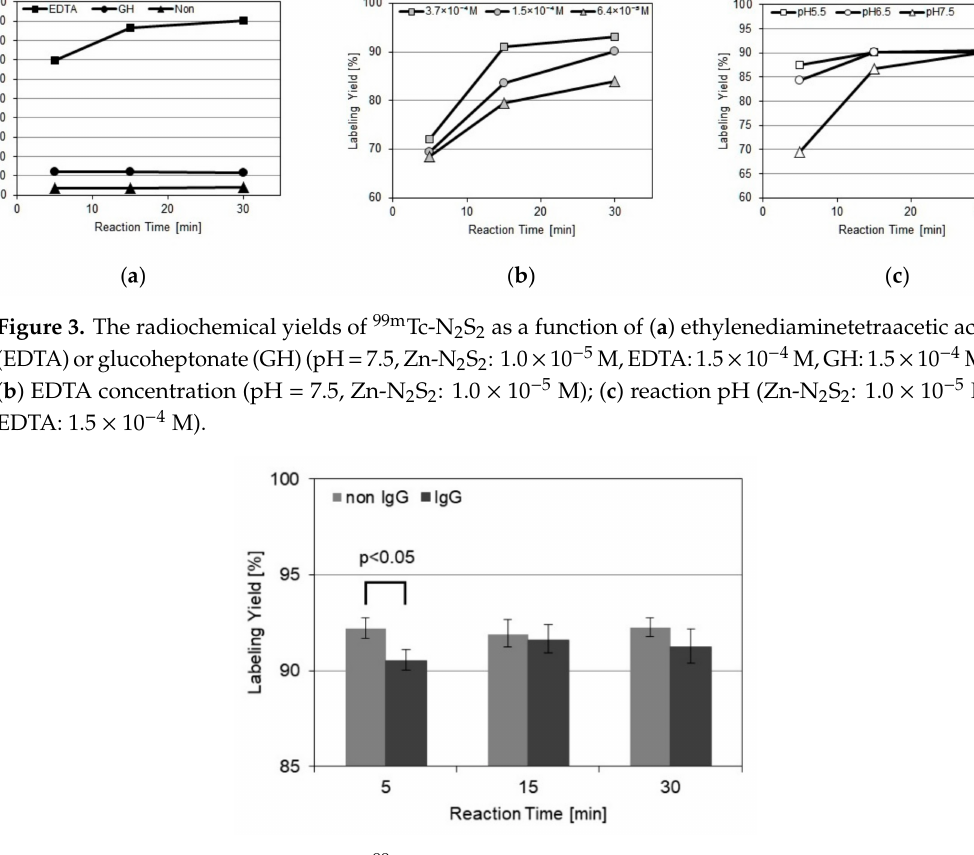
Figure 4. The radiochemical yields of 99m Tc-N 2 S 2 in the presence or absence of an equimolar amount of IgG (EDTA: 1.5 × 10 − 4 M, pH = 5.5, Zn-N 2 S 2 : 1.0 × 10 − 5 M, IgG: 0, or 1.0 × 10 − 5